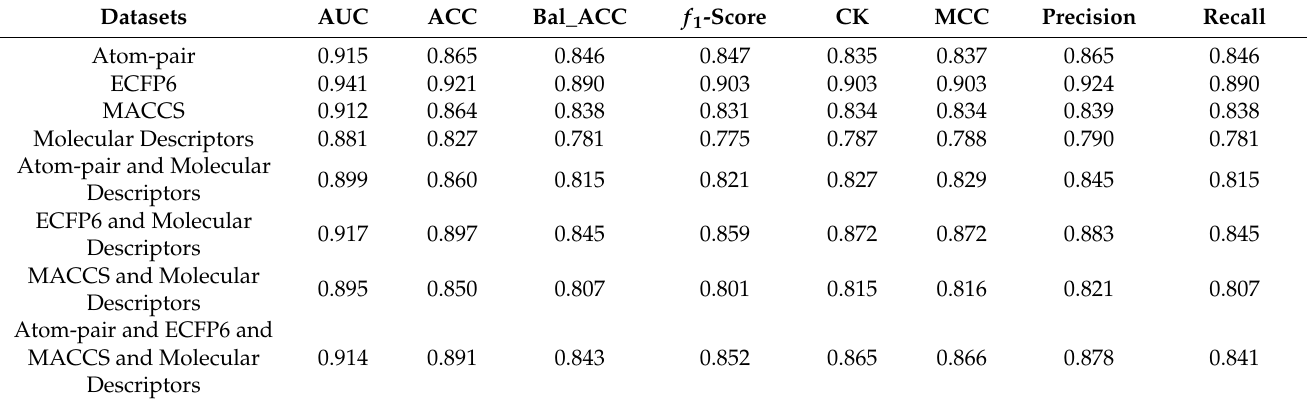
Table 5. Overall Performance Comparison of Different Feature Types (Average over Nine Datasets on All ML